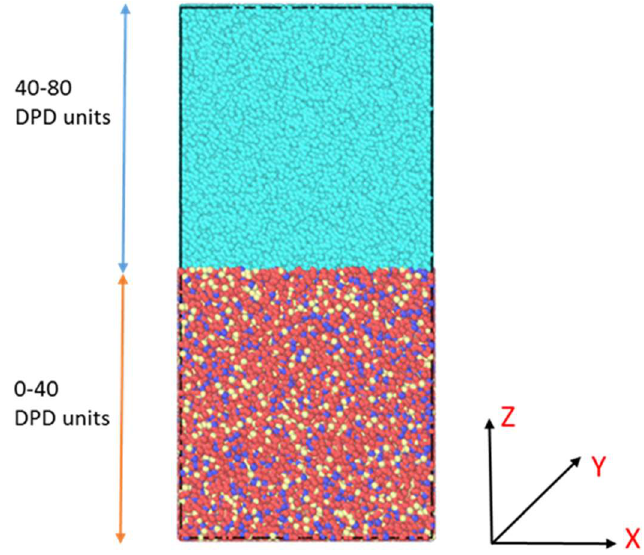
Figure 2. Initial configuration of the simulation box which ranges from 0 to 80 dissipative particle dynamics (DPD) units in the Z-direction. The bottom half of the box, i.e., 0–40 DPD units in the Z-direction are composed of the polyelectrolyte membrane (PEM) beads and the top half of the box, i.e., 40–80 DPD units in the Z-directions are composed of water beads.